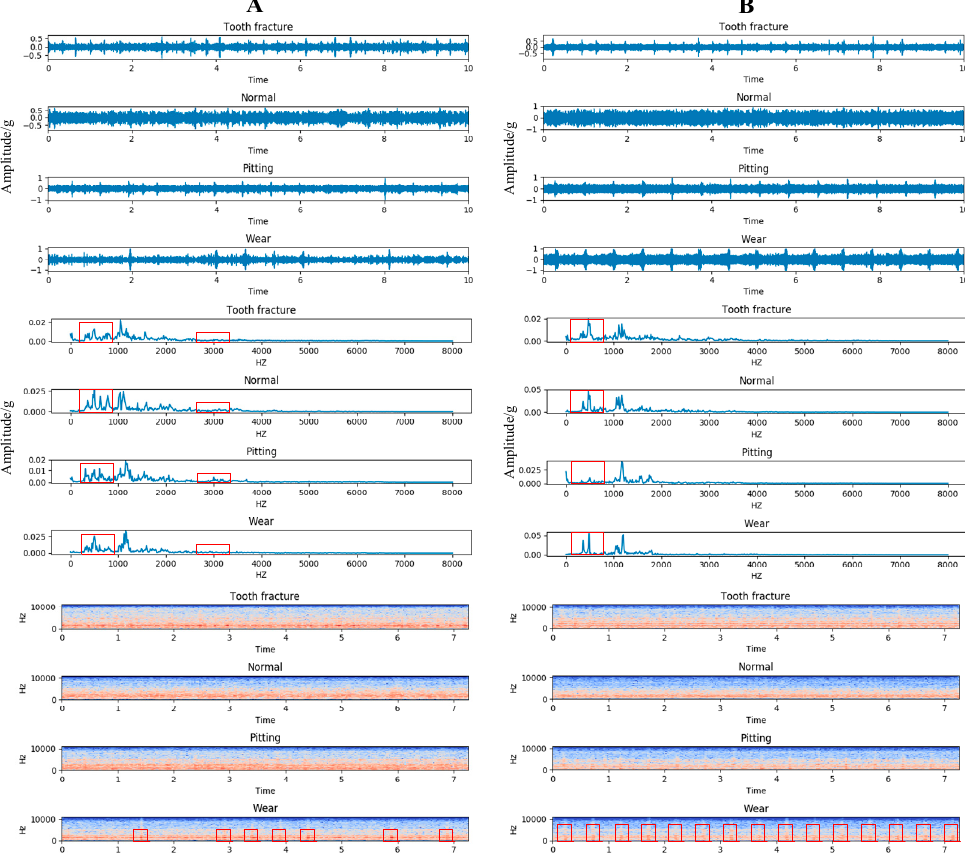
Figure 7. Four different types of gear signals in time, frequency, and time–frequency domains under two-load conditions. ( A ) Represents a no-load condition and ( B ) represents a load condition.